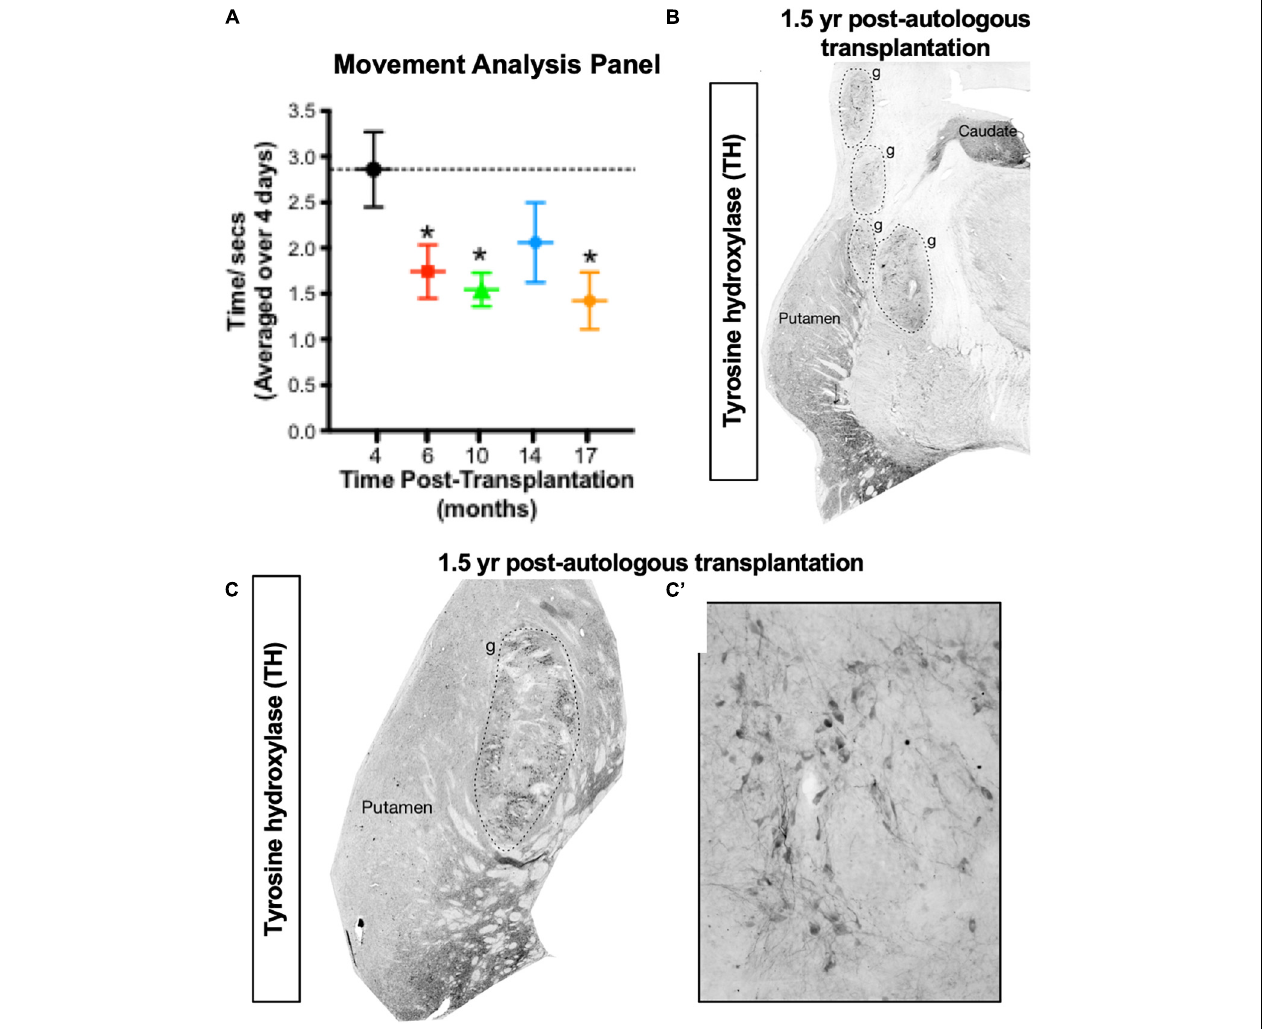
FIGURE 4 | Proof of concept for the autologous transplantation approach in parkinsonian NHPs. (A,B) Autologous transplantation of iPSC-mDA cells into the left putamen of an MPTP-lesioned primate provides functional improvement in the right (contralateral) forelimb in an automated Movement Analysis Panel (A) , and survival of dopamine (TH+) neurons ( > 20,000) in the transplanted putamen (B) . (C,C’) Robust survival of TH + neurons at 1.5 years following autologous transplantation of iPSC-mDA cells into the left putamen of an additional MPTP-lesioned NHP (Osborn et al., 2020). These recent NHP data are supportive of our previous NHP findings (Hallett et al.,